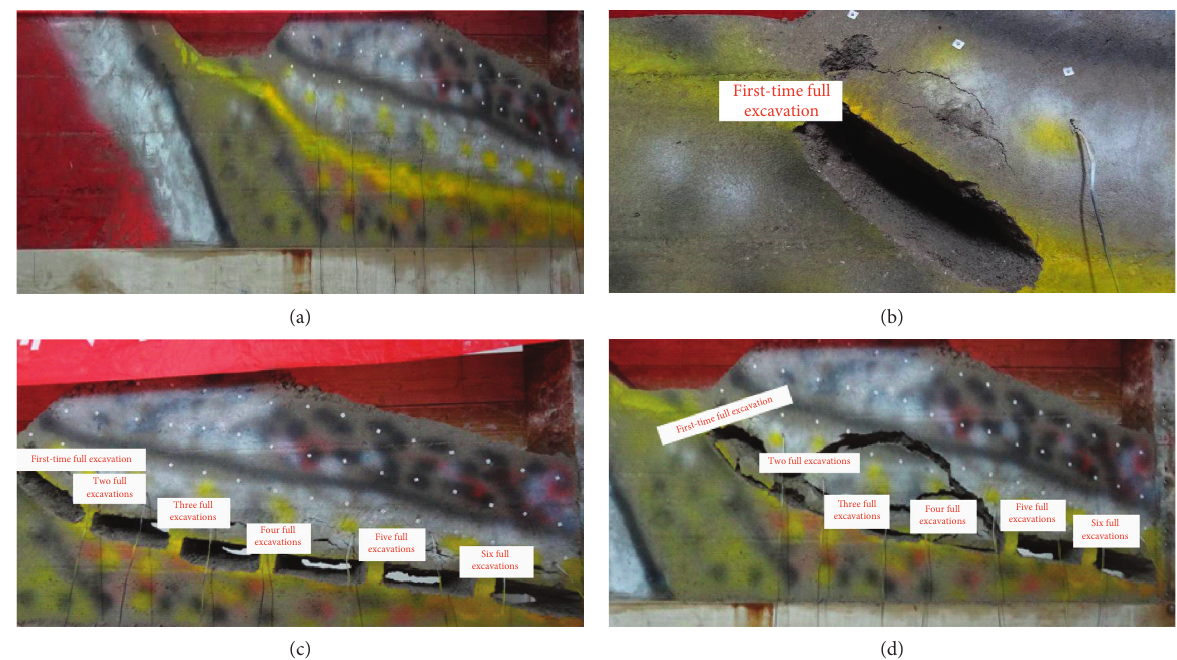
Figure 10: Damage condition of overlying strata after multiexcavations (20 ° ). (a) Model before experiment (20 ° ). (b) Damage condition of overlying strata after the first exploit progress (20 ° ). (c) Damage condition of overlying strata after the second to sixth exploit progress (20 ° ). (d) Damage condition of overlying strata after the number one to five ore pillar recovery (20 ° ).